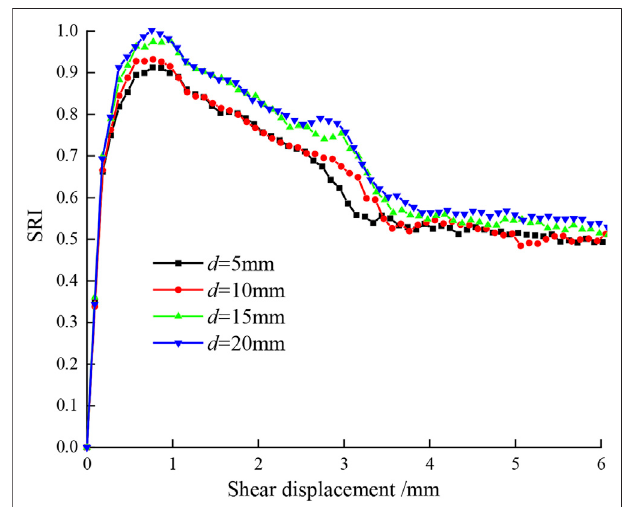
FIGURE 10 | Shear-normal displacement relation of J3 with different spacings.